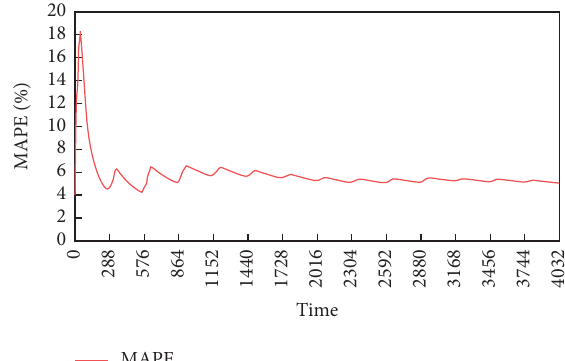
Figure 7: MAPE curve of CDLP model for the test set.